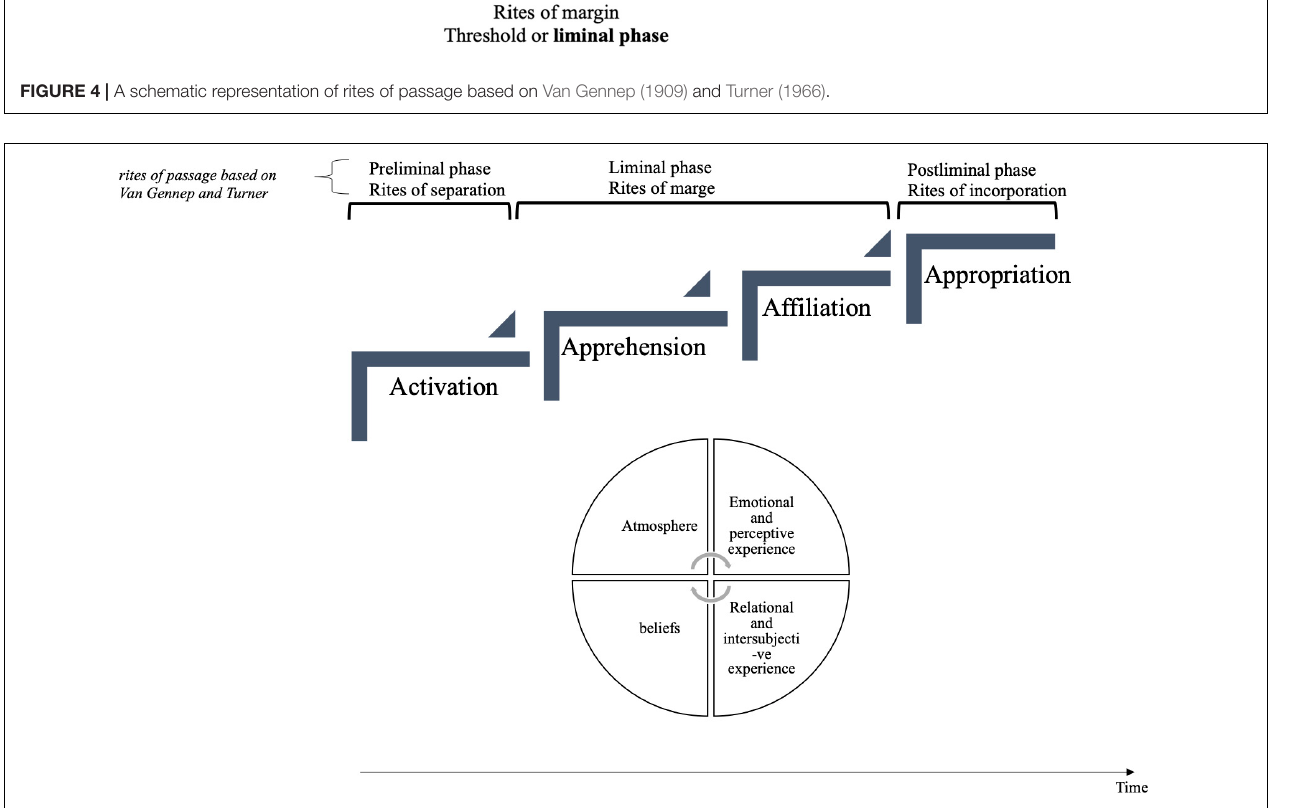
FIGURE 5 | Being welcomed as a rite of